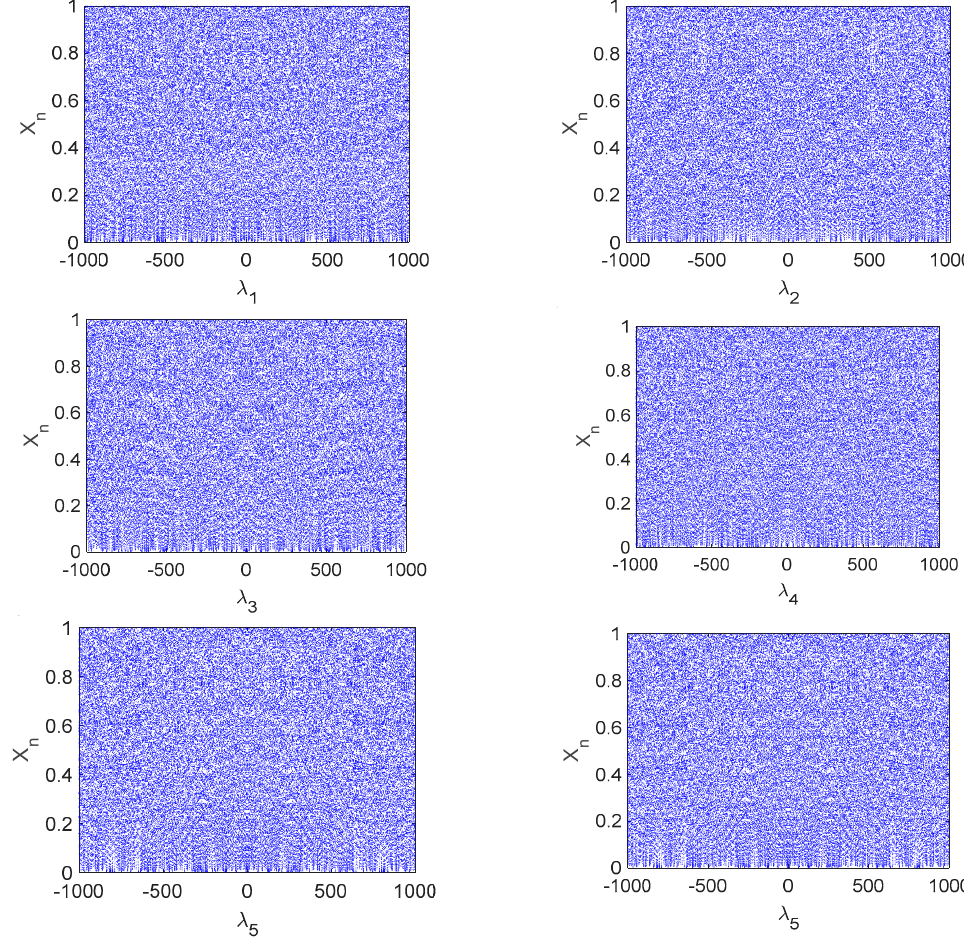
Figure 3. Bifurcation diagrams corresponding to the proposed MTM parameters with T 0 =